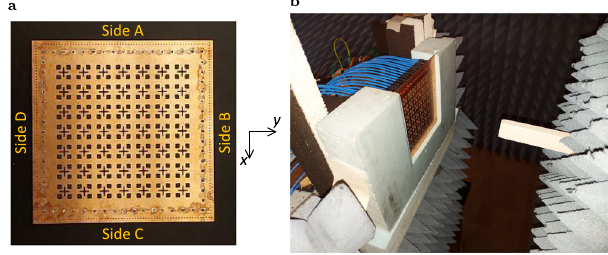
Fig. 5 PEX array measurement. a Top view of the fabricated 7 × 7 PEX antenna array prototype which is etched on a Rogers RT/duroid 5880 1oz substrate, showing the different sides of the array A, B, C and D, and the coordinate system used. (Dimensions = 131.4 mm × 131.4 mm × 1.575 mm). b A photo of the near- fi eld scanning experimental setup used, showing the PEX prototype and the waveguide probe using to measure the near- fi eld radiation from the